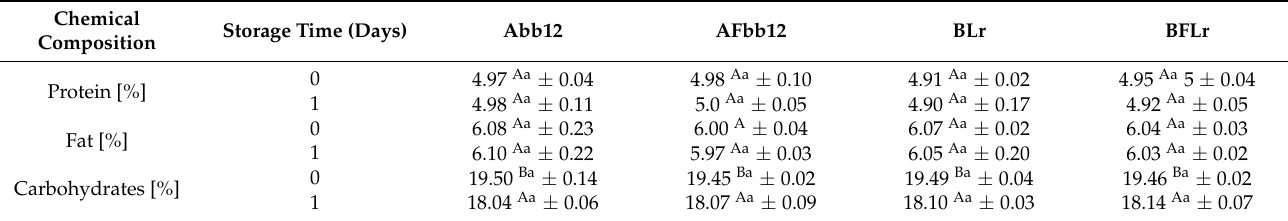
Table 2. Table 1. Chemical composition of ice cream mixture samples.